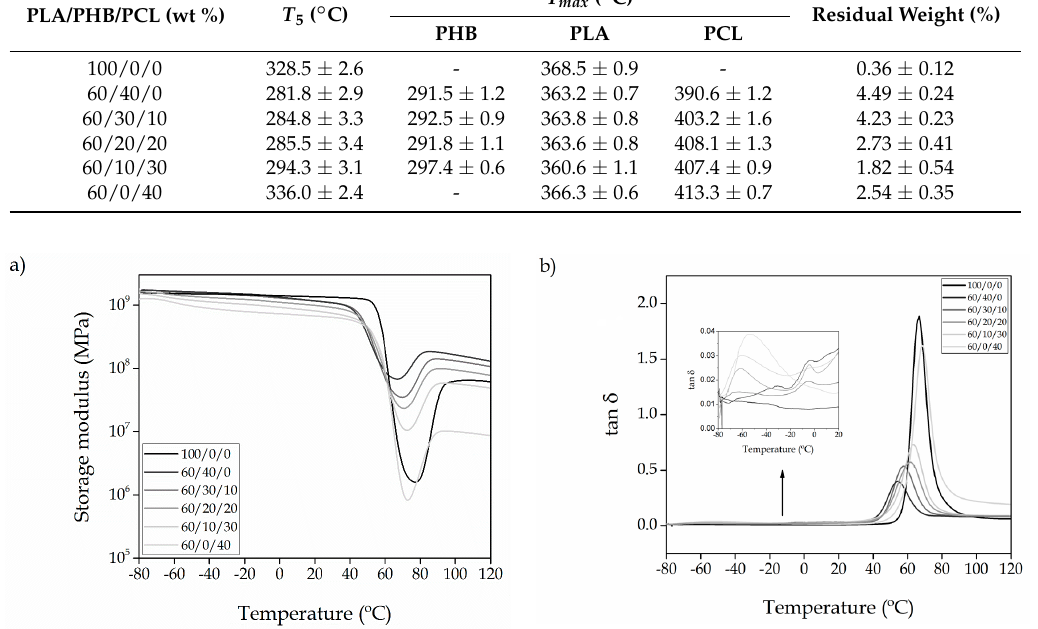
Figure 6. Plot comparison of the dynamic mechanical thermal behavior of PLA/PHB/PCL ternary blends with different compositions (wt % PLA/wt % PHB/wt % PCL); ( a ) storage modulus, G’; and ( b ) damping factor, tan δ .